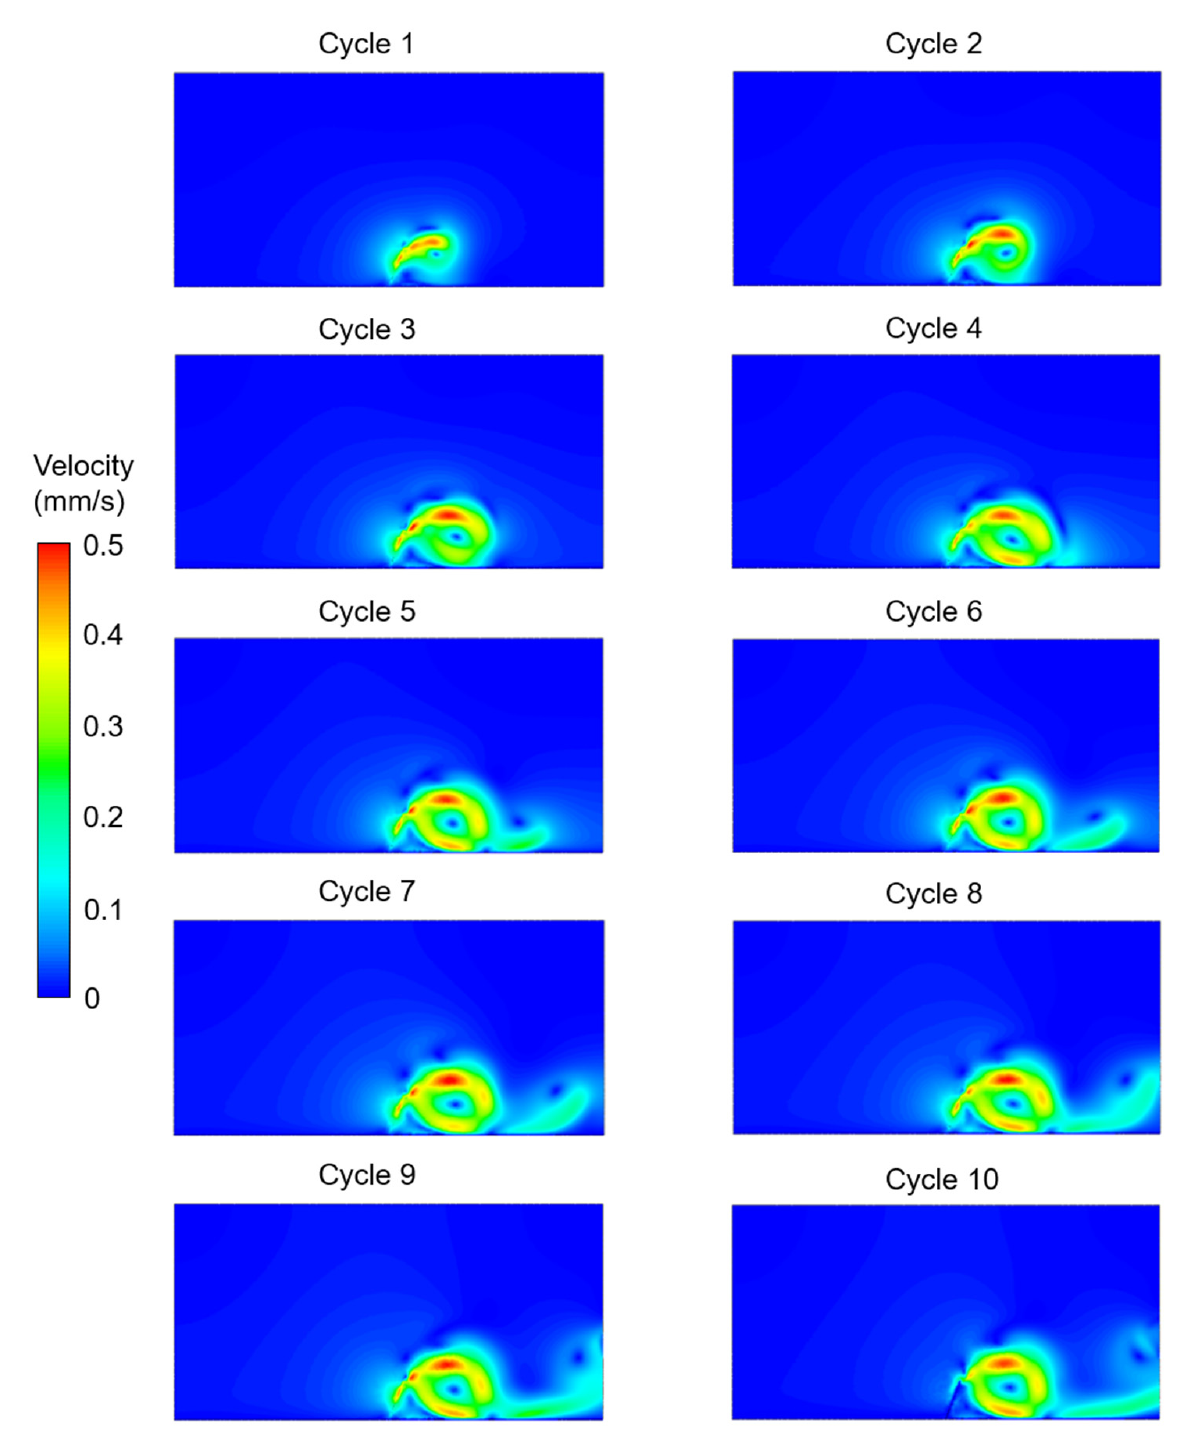
Figure 4. Velocity contour plots of Case 2 for a single cilium with a 50 ◦ cilium tilt angle. The flow fields are provided at the end of each ciliary cycle.